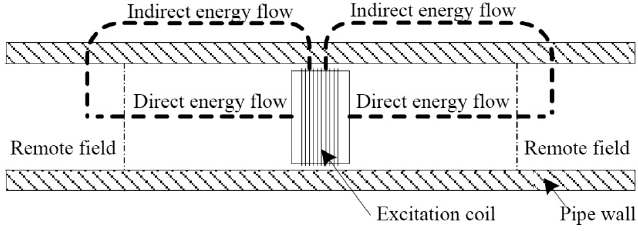
Figure 17. Schematic diagram of the electromagnetic eddy current inspection principle.